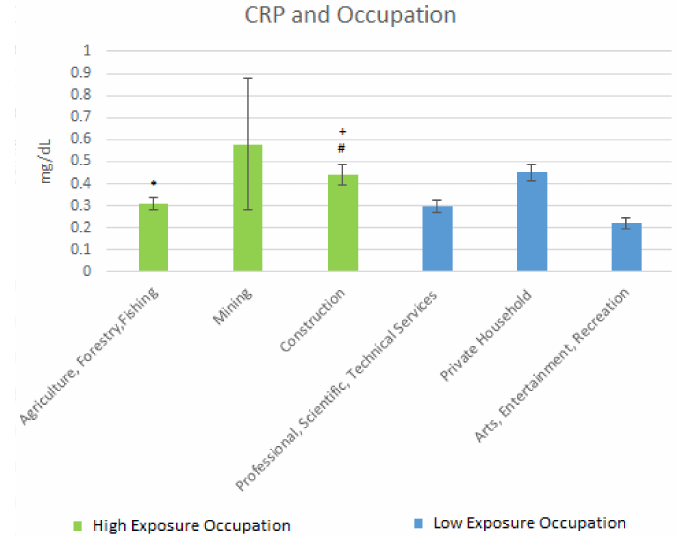
Figure 4. Occupation and CRP Levels. * Significant difference between Agriculture, Forestry, Fishing and Arts, Entertainment, and Recreation; + Significant difference between construction and Professional, Scientific and Technical services; # Significant difference between construction and Arts, Entertainment, and Recreation.